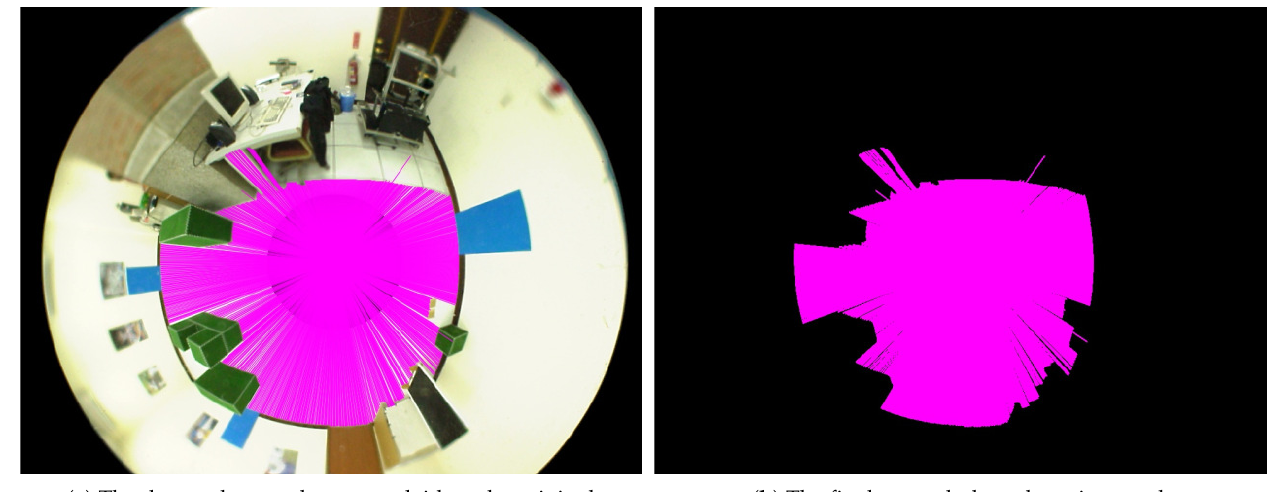
( a ) The detected ground rays overlaid on the original image. Figure 5. The detection of the ground plane region from the omnidirectional image using edge detection and the rays radiated from the image center.